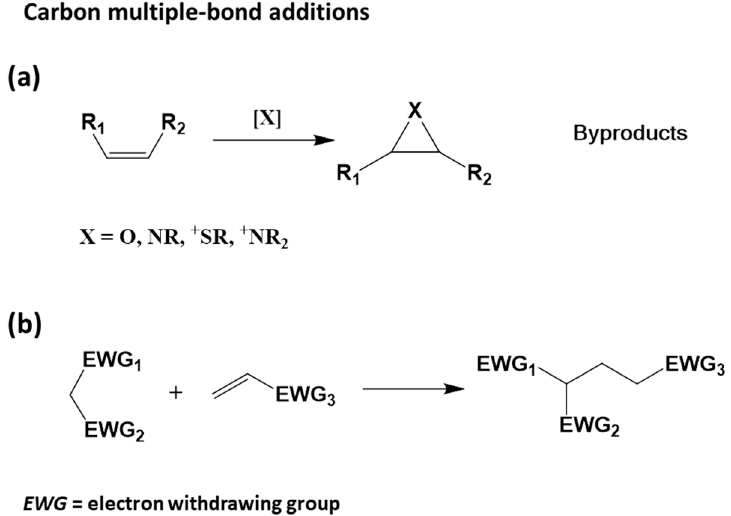
Figure 16. Schematic representations of additions to carbon–carbon multiple-bond click reactions for the formation of ( a ) various three-member rings and ( b ) certain Michael additions.